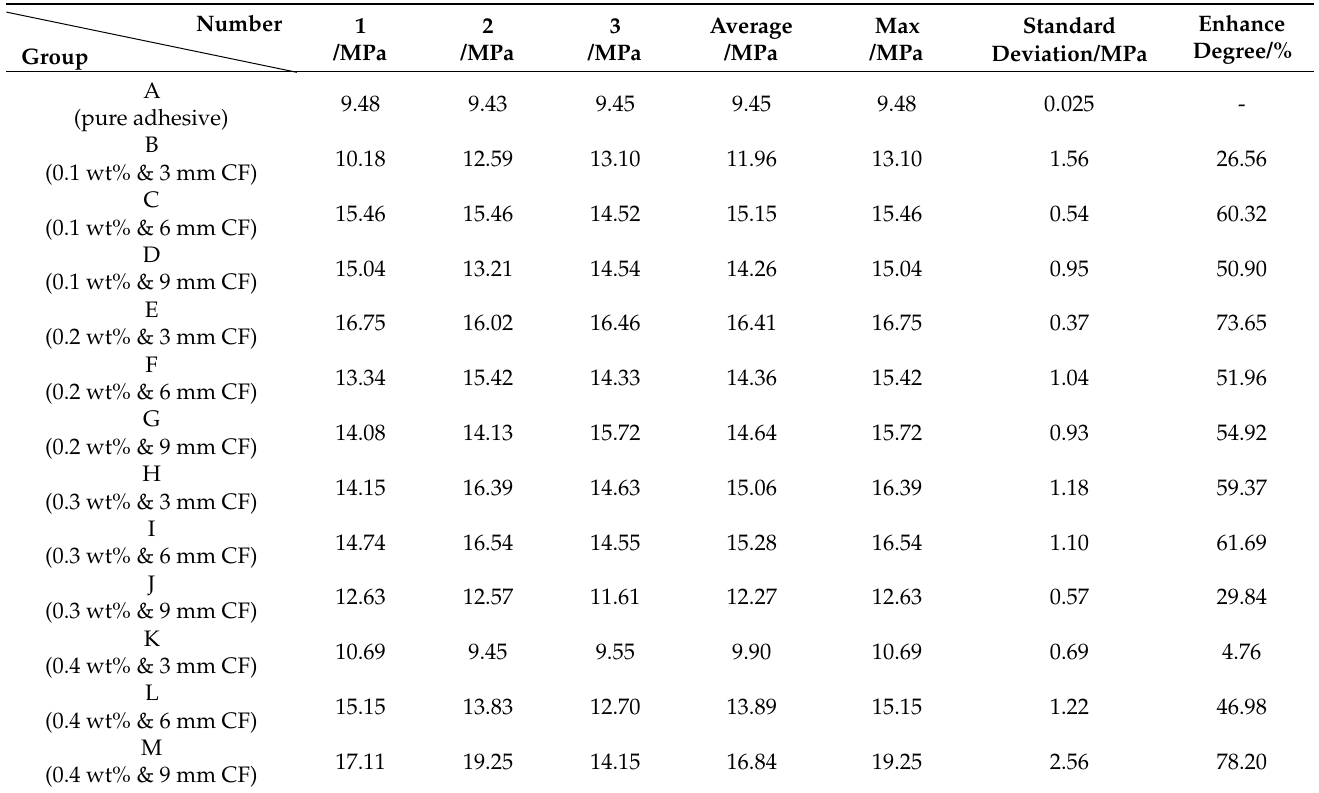
Table 3. Shear strength of each